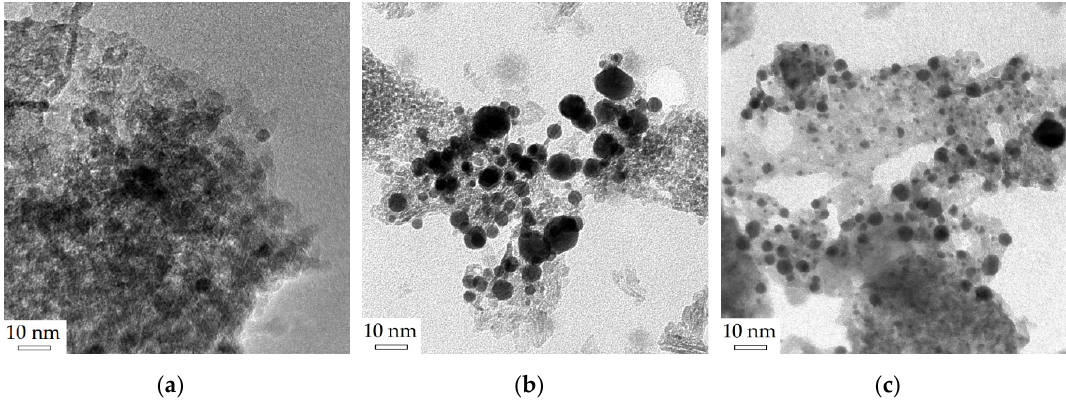
Figure 1. TEM-microphotographs of samples: ( a ) Pd/Al 2 O 3 ; ( b ) PdBi/Al 2 O 3 ; ( c ) Pd → Bi/Al 2 O 3 .